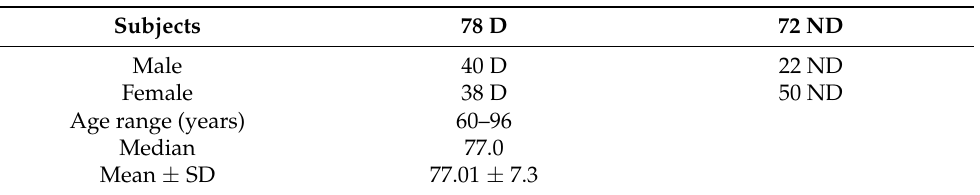
Table 1. Demographic characteristics of the subjects investigated (D: demented; ND: nondemented; SD: standard